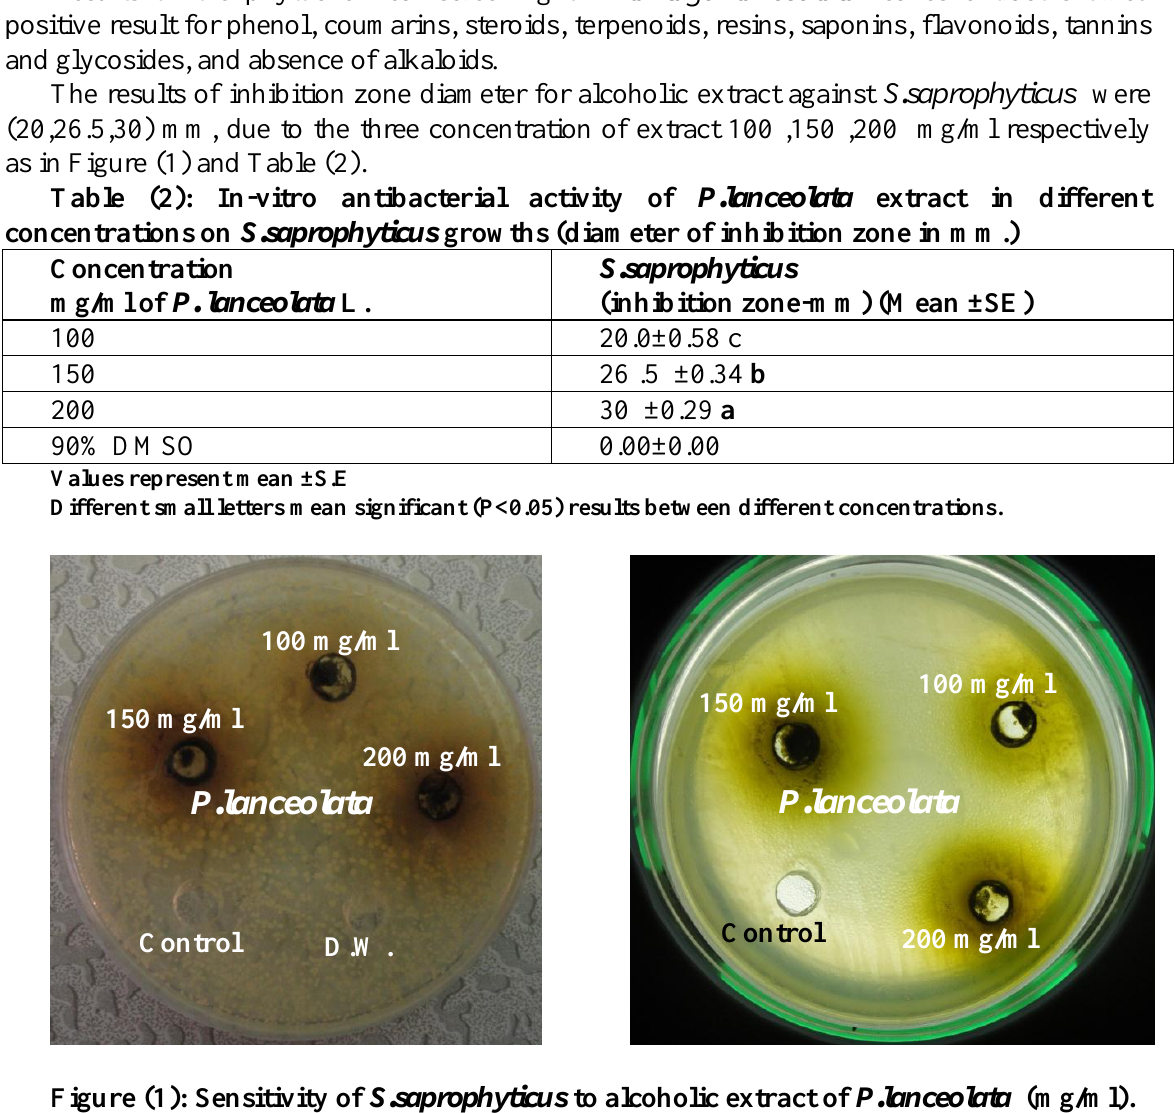
Figure (1): Sensitivity of S.saprophyticus to alcoholic extract of P.lanceolata (mg/ml).